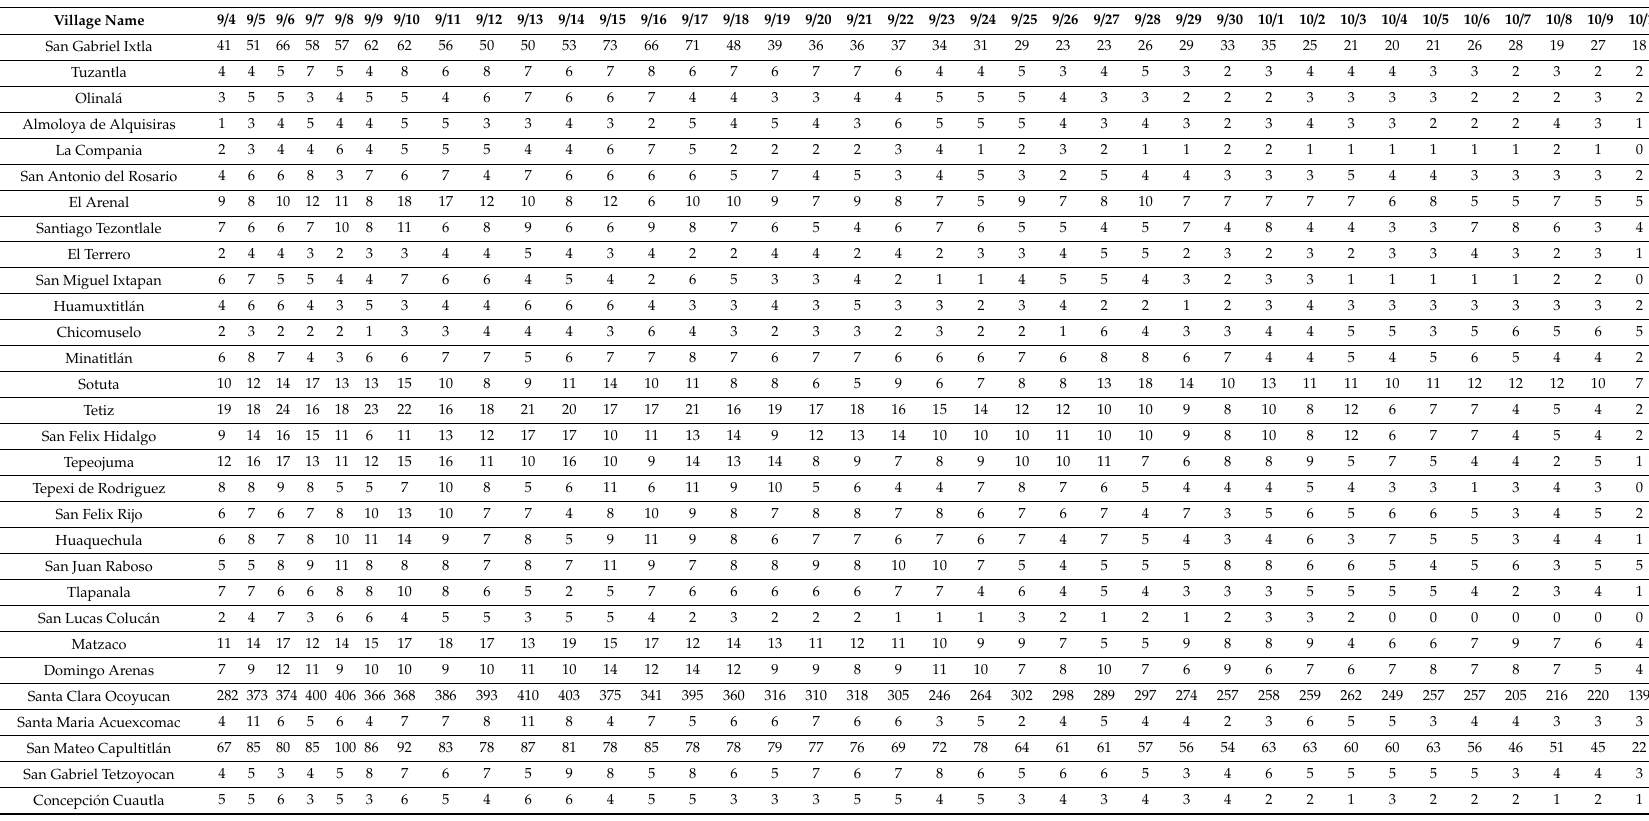
Table A4. The resident counts for the 30 localities for each of the 37 days were used to calculate their slope before and after the earthquake (Table A5).